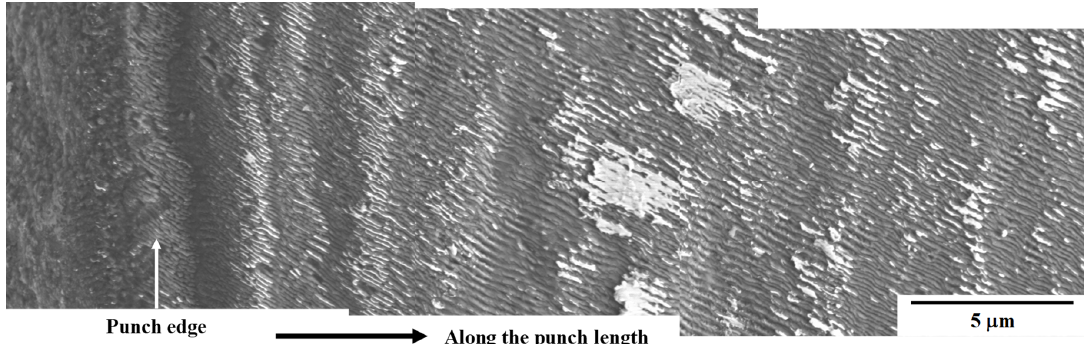
Figure 11. SEM image on the nanotextured side surface of the punch from the punch edge along the punch length after piercing 100 holes into the AISI316L sheets.